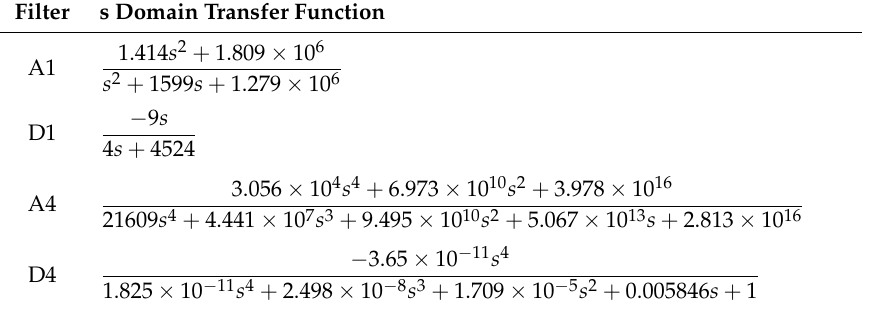
Figure 3. Magnitude, group delay, and group delay error after fixed delay compensation, responses for the DWT and ADWT with base sampling frequency 360 Hz. First order filter Daubechies 1 mother wavelet is shown with passband gain normalized to 0 dB. Table 2. Analog transfer functions to match DWT wavelets from Table 1 with base sampling frequency 360